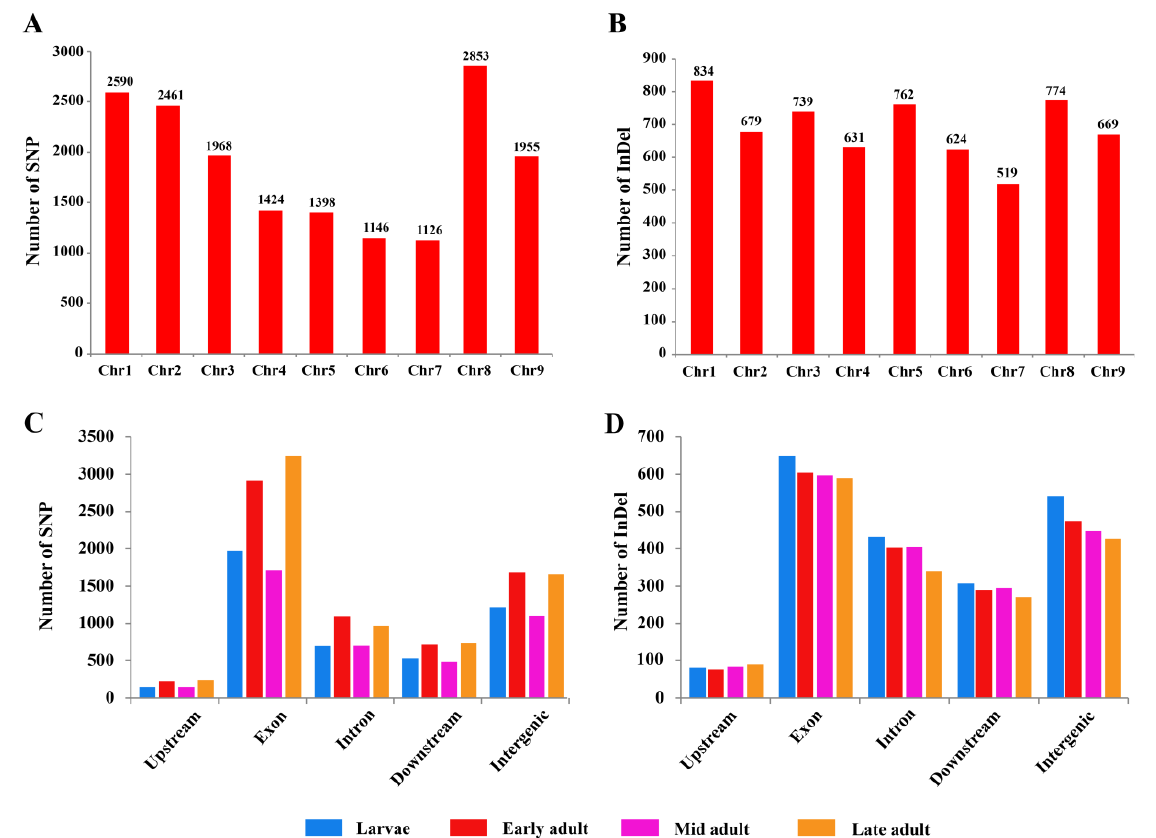
Figure 3. SNP and InDel distribution across Kerria lacca : ( A ) chromosomal distribution of SNPs, ( B) chromosomal distribution of InDels, ( C ) stage-wise SNP annotation, and ( D ) stage-wise InDel annotation.